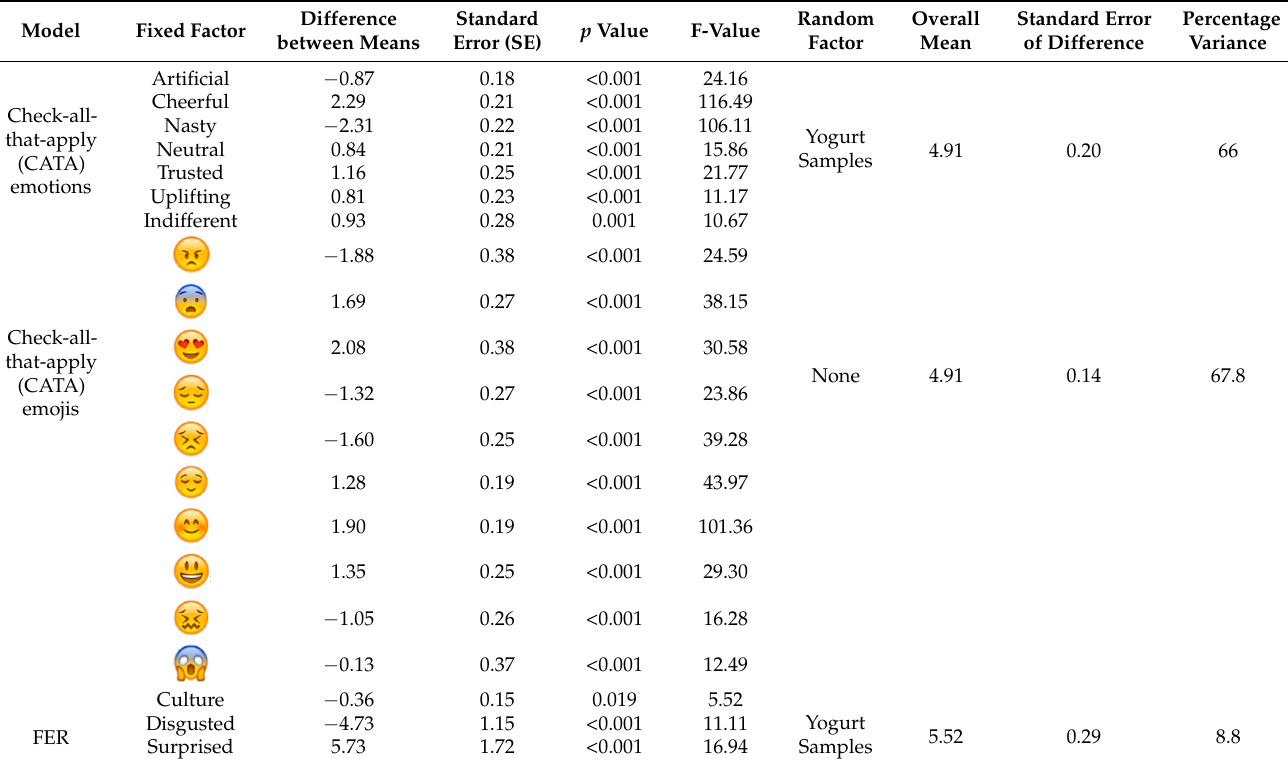
Table 3. Cochran’s Q test for emoji terms shown for the two cultural groups (Western consumers, Asian consumers) comparing terms within the culture, and using Fisher’s test to compare terms across cultures.